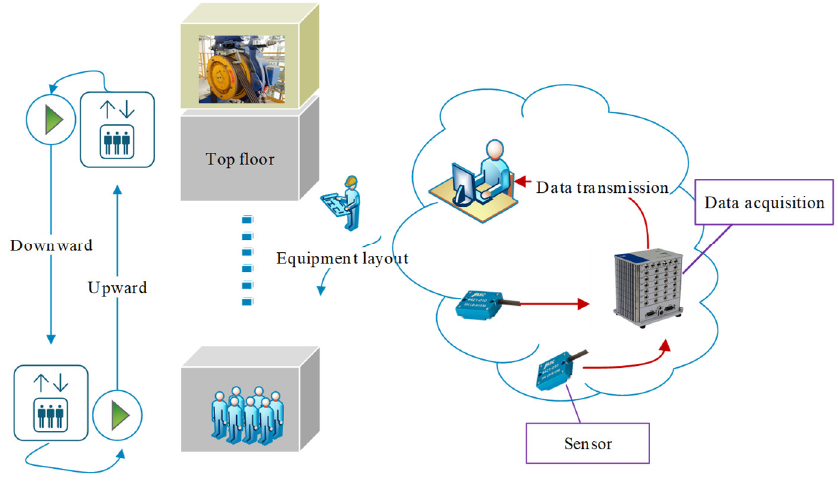
Figure 3. Test process and experimental setup.